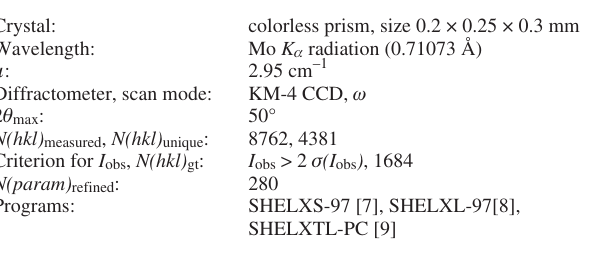
Table 1. Data collection and